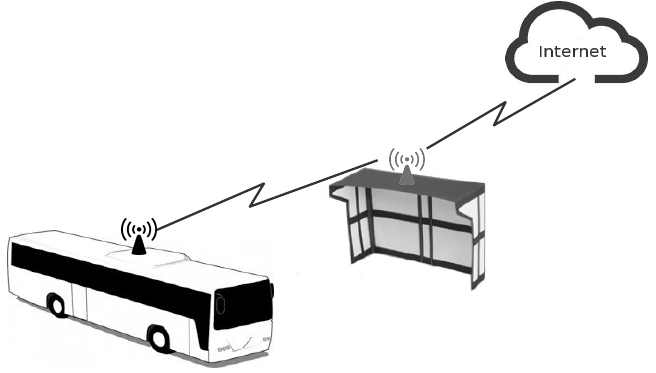
Figure 1. Vehicle to roadside access point example.